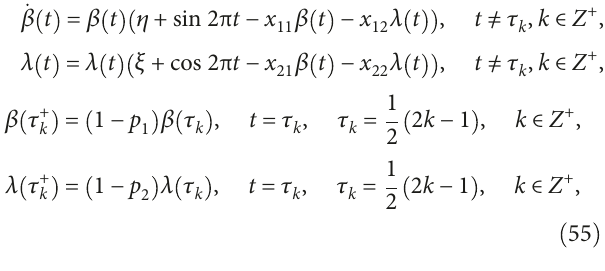
Figure 3: The time-sequence comparison chart of the two groups under oscillating collaborative